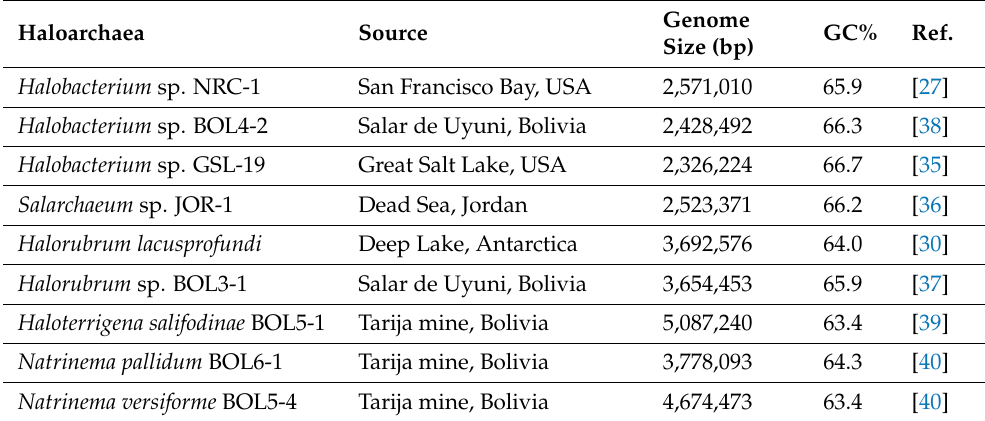
Table 1. Microorganisms used in the